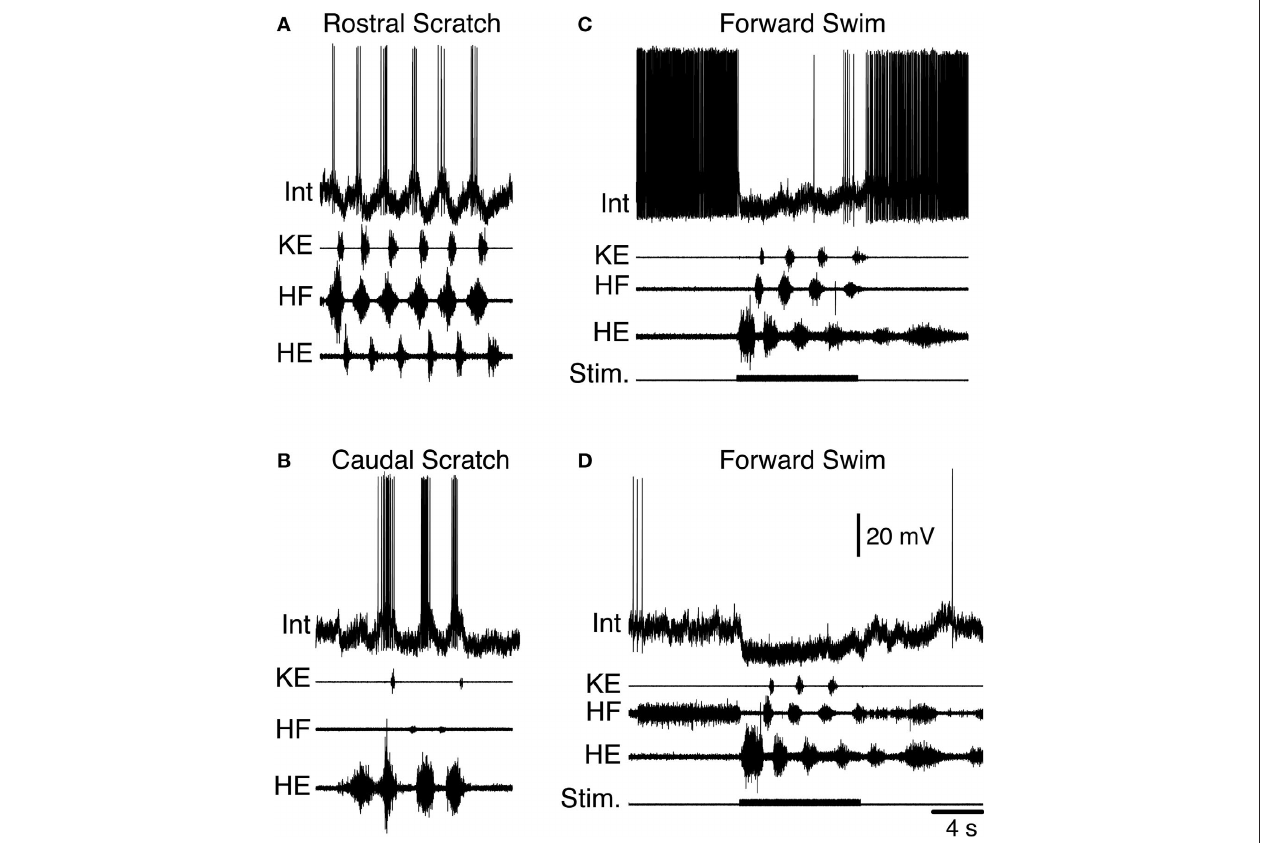
seconds beyond the swim-evoking stimulus, as the motor pattern continues. KE, knee extensor; HF, hip flexor; HE, hip extensor; Stim., stimulus. Modified from Berkowitz (2008), with permission of the American Physiological